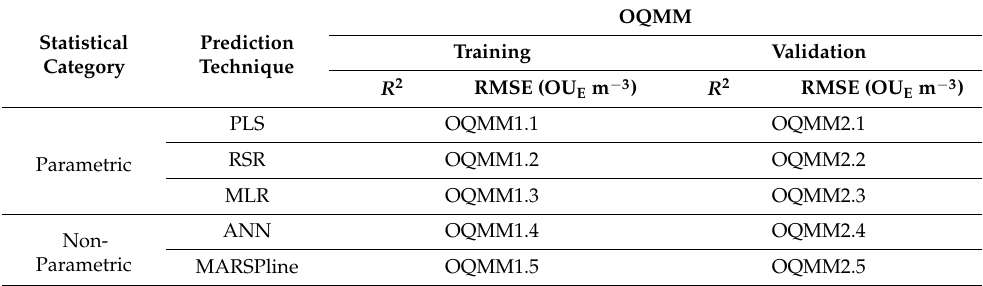
Table 3. Matrix of the different elaborated and compared OQMMs.